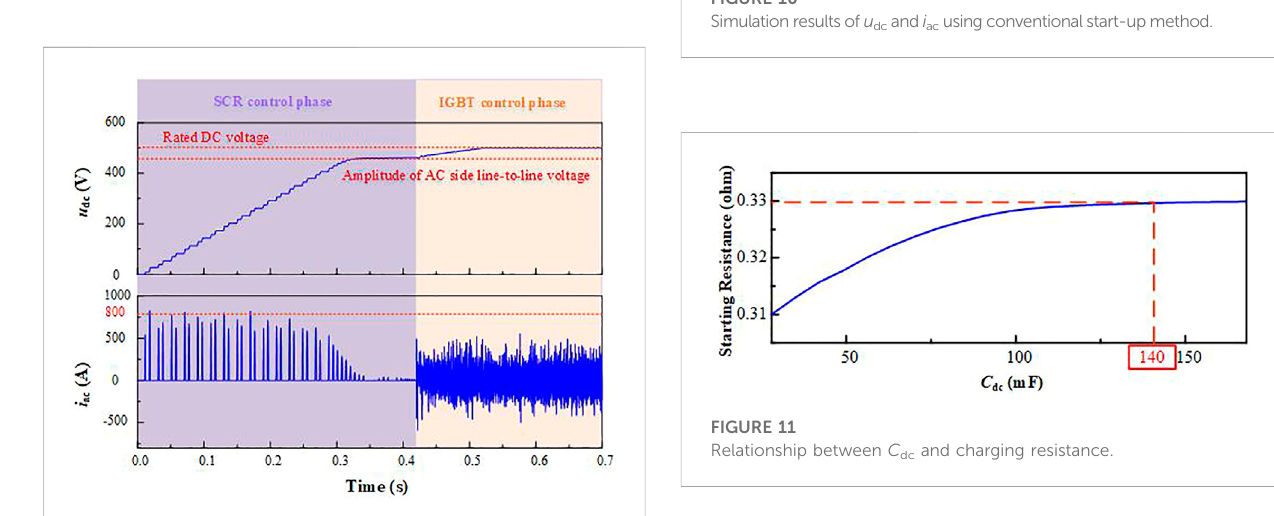
FIGURE 9 Simulationresultsof u dc and i ac usingtheproposedsoftstart-upmethod.